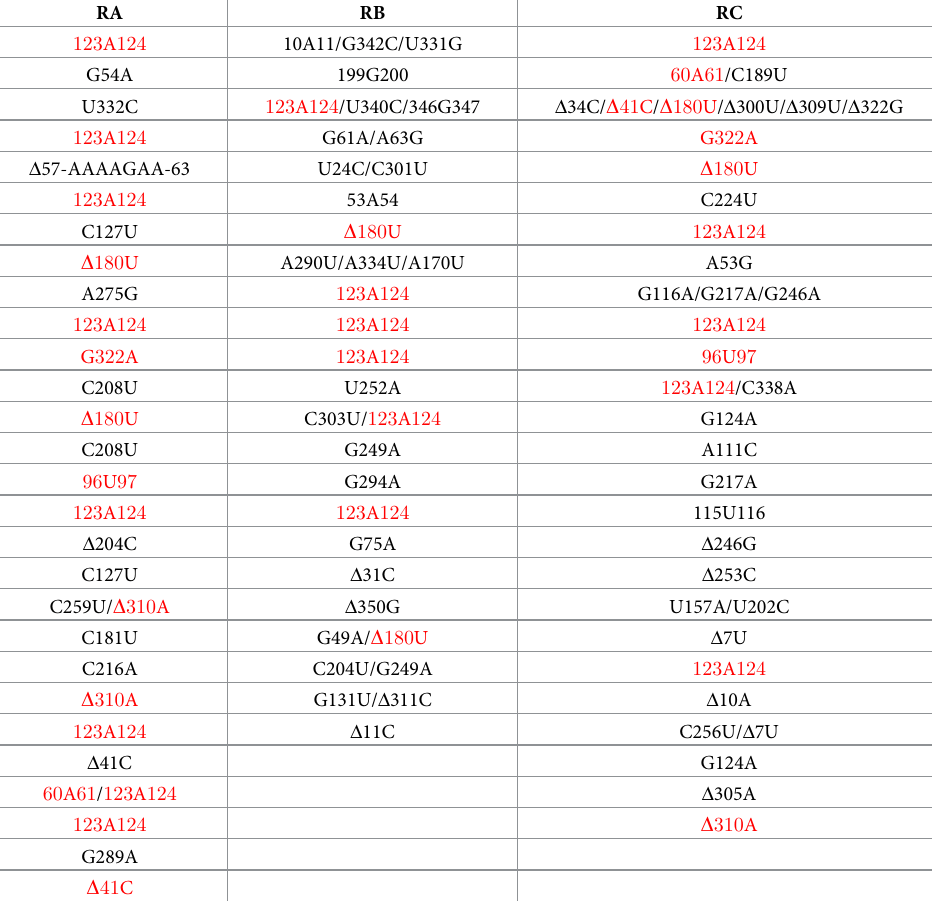
Table 2. Unshared de novo mutations identified in PSTVd (-)-strand